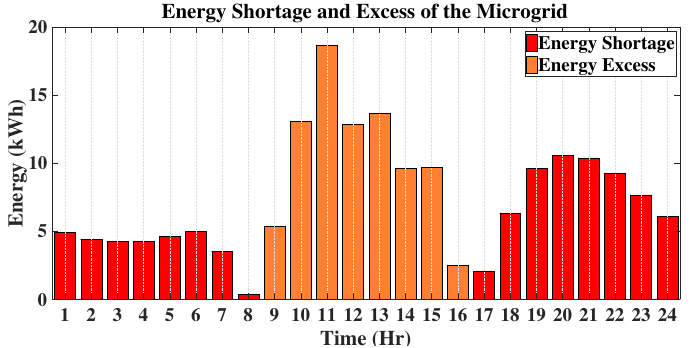
Figure 19. Overall energy shortage and excess without sharing among the neighbours in a microgrid.